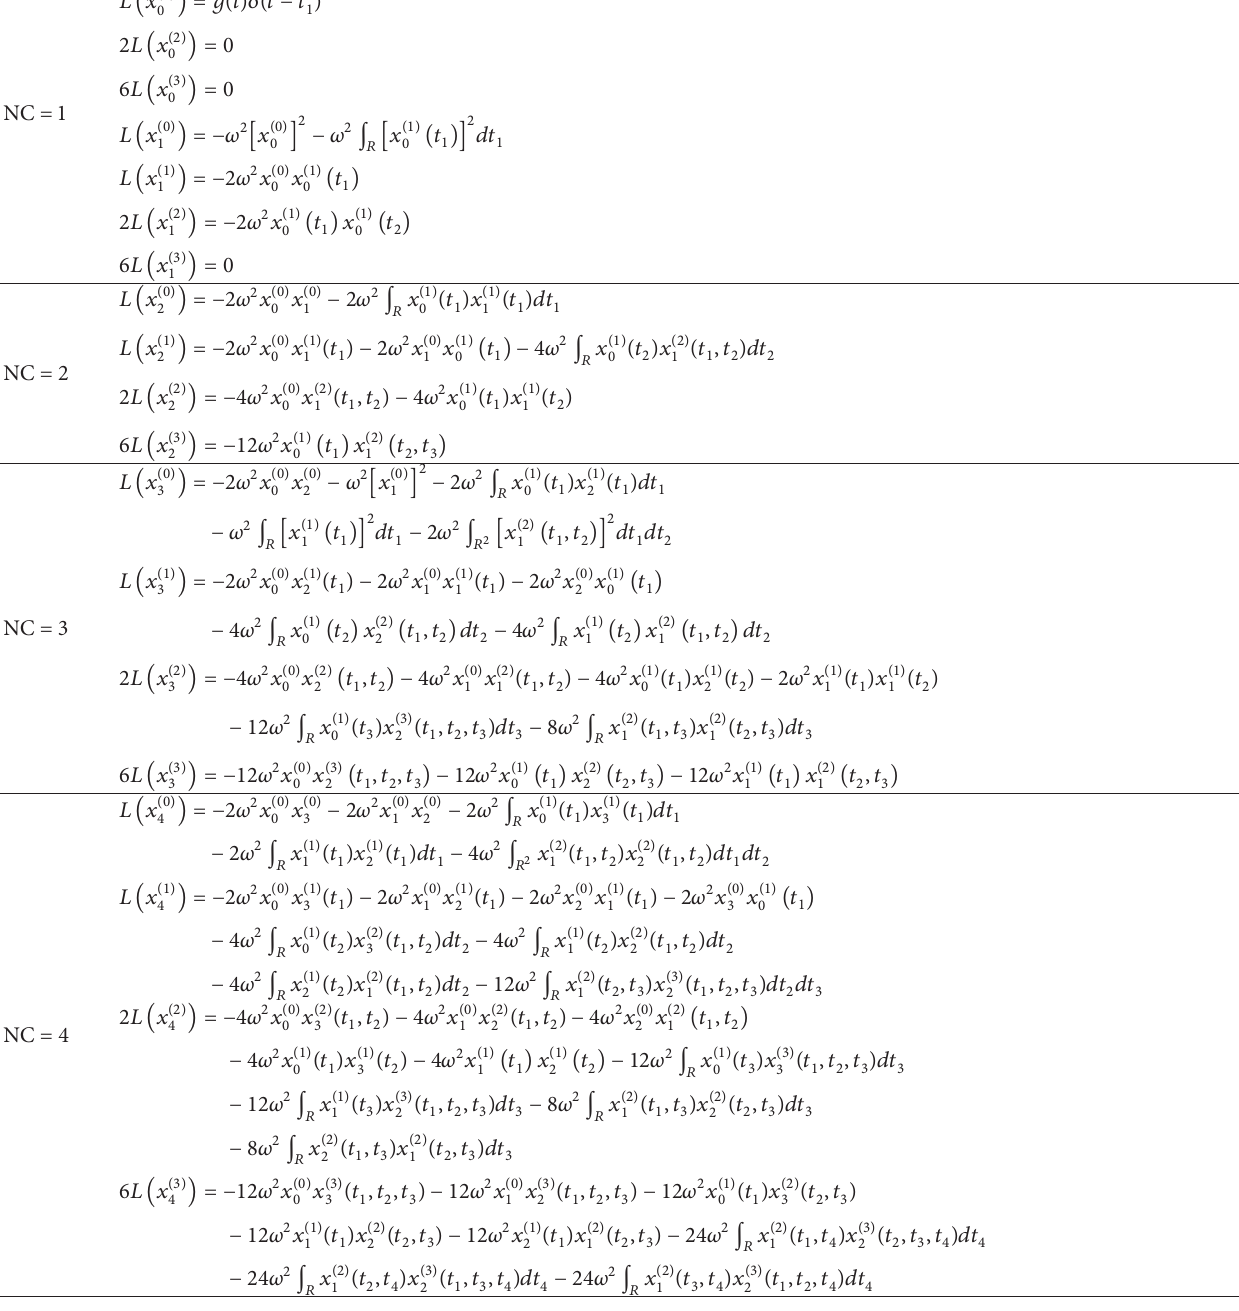
Table 3: The equivalent deterministic system for third-order approximation with different number of corrections